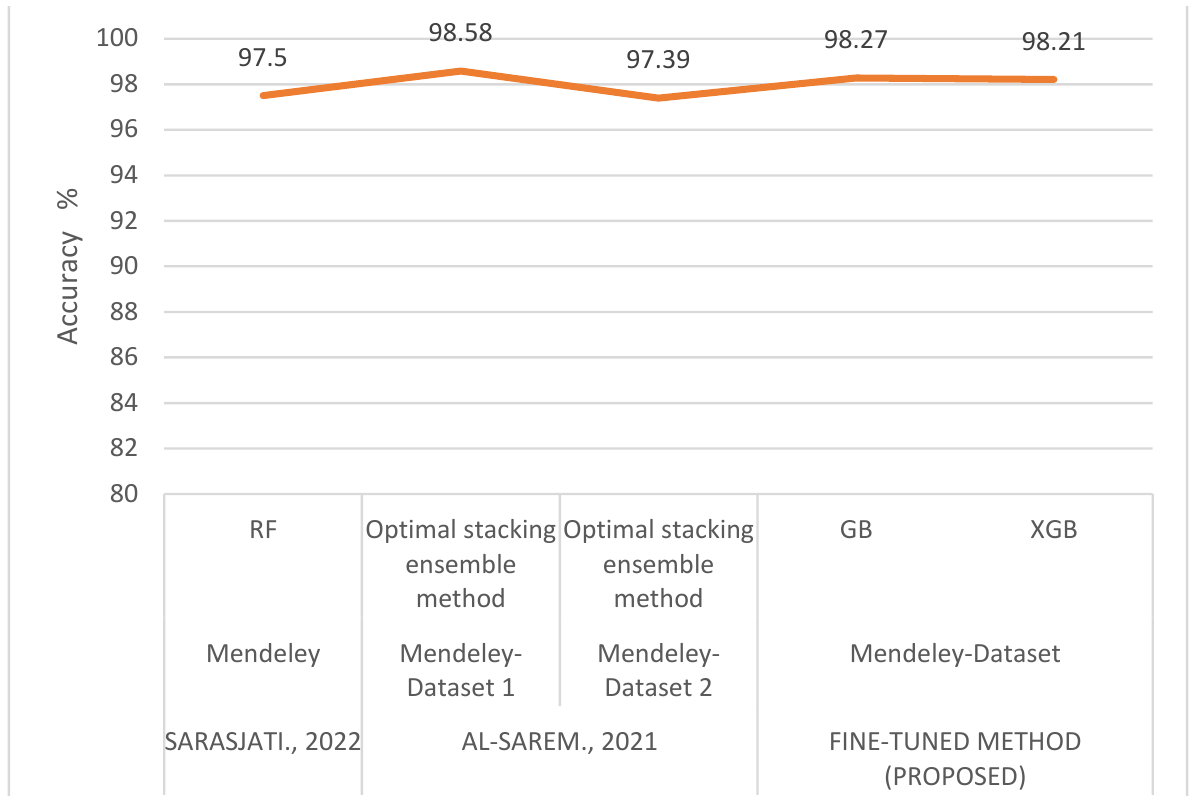
Figure 10. Performance comparison of existing and fine-tuned system for UCI dataset [12–16,19].